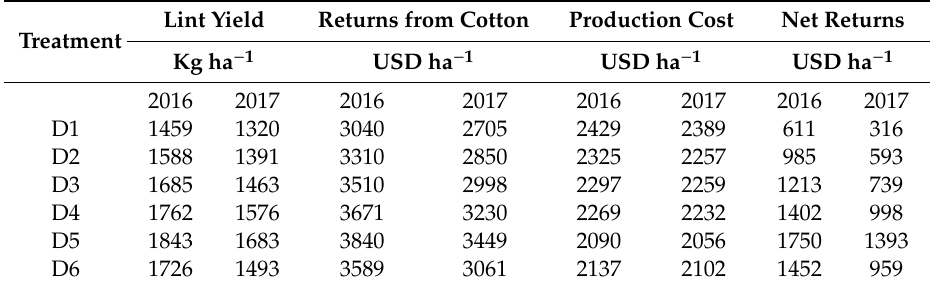
Table 11. Cotton yield, production cost, and net returns of 2016 and 2017. Lint Yield Returns from Treatment